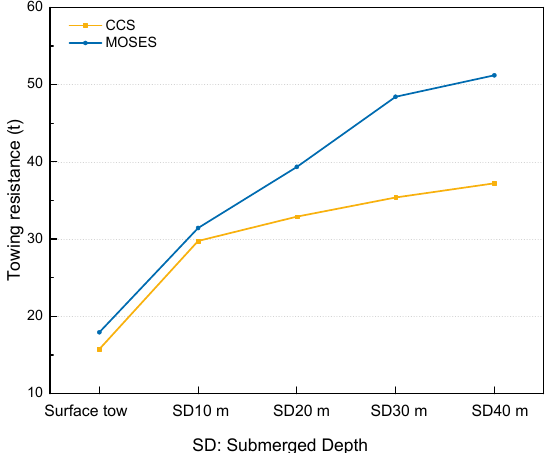
Figure 3. Towing resistances by two method (MOSES and CCS code) under surface tow and submerged